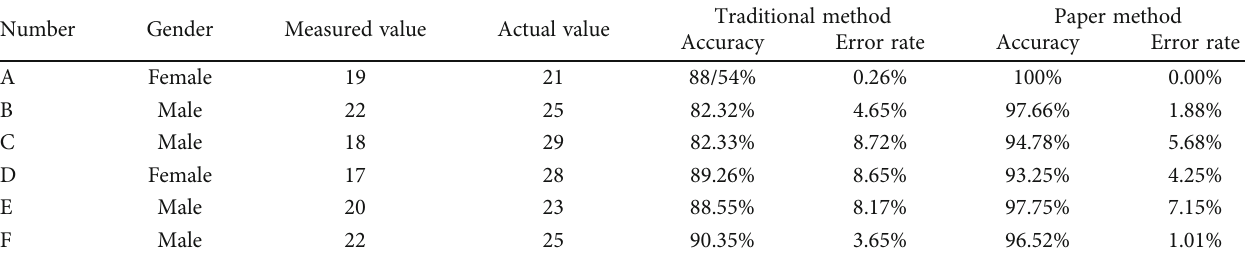
Table 6: Comparison of big data respiratory rate evaluation results.